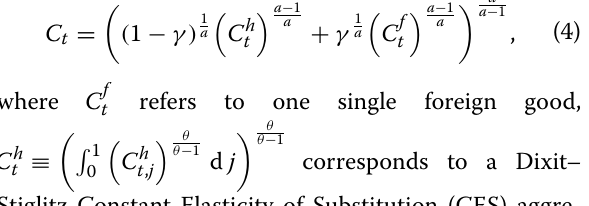
Stiglitz Constant Elasticity of Substitution (CES) aggre- gate of domestic goods, and C exact composition C